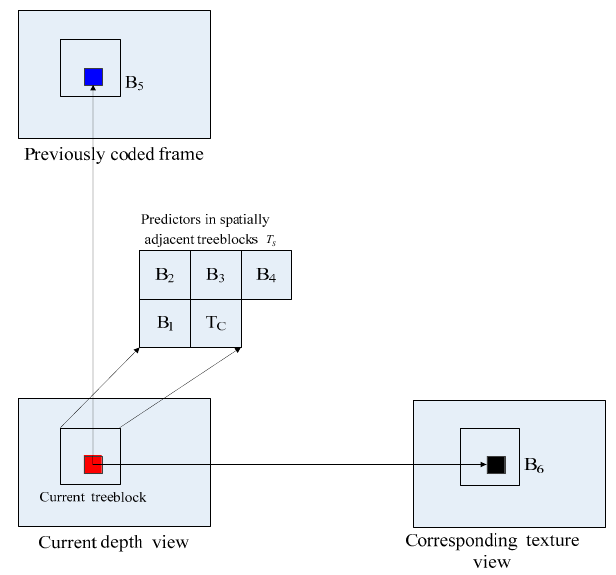
Figure 1. Predictors of the treeblock in depth view.